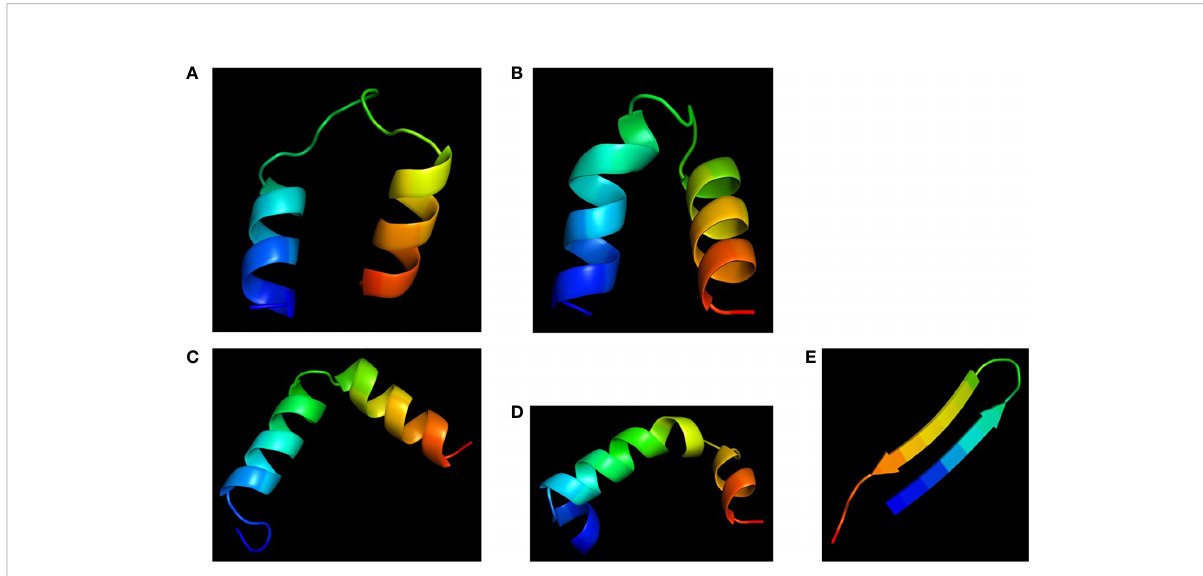
FIGURE 5 Cartoon diagrams ( blue to red from N- to C-terminal) of the different peptides. (A) 30P-3, KKLPKKILKILGSGYGSPGFWQRRIRRWRR. (B) UGK-13, KKLPEKILKILESGYGSPGFWQRRIRRWRR. (C) UGK-17, KKLPEKILKILESLKGSPGFWQRRIRRWRR. (D) UGK-9, RLPEAFQWQRNIRKVRRPDSPGRRWW RWWR. (E) L19GA, KC2RRLC6YKQRC11VTYC15RGRQ (S – S bridges: C2-C15 and